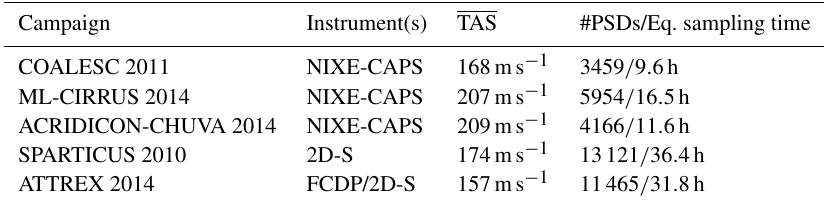
Table 1. Description of the in situ campaigns. The numbers correspond to PSDs averaged over 10s periods and for ice clouds with T c < − 30 ◦ C. TAS refers to the average true air